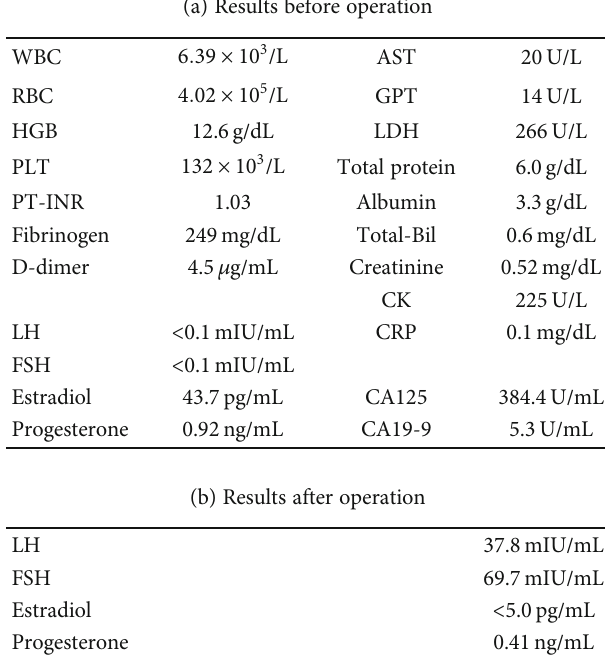
Table 1: Results of blood examination. (a) Results before